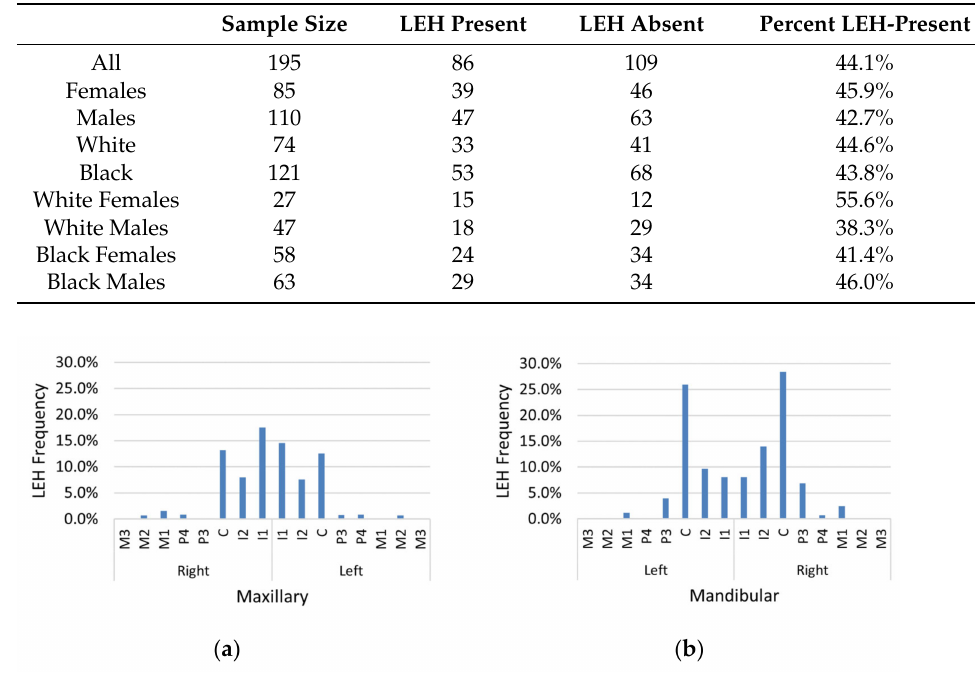
Table 1. LEH presence.